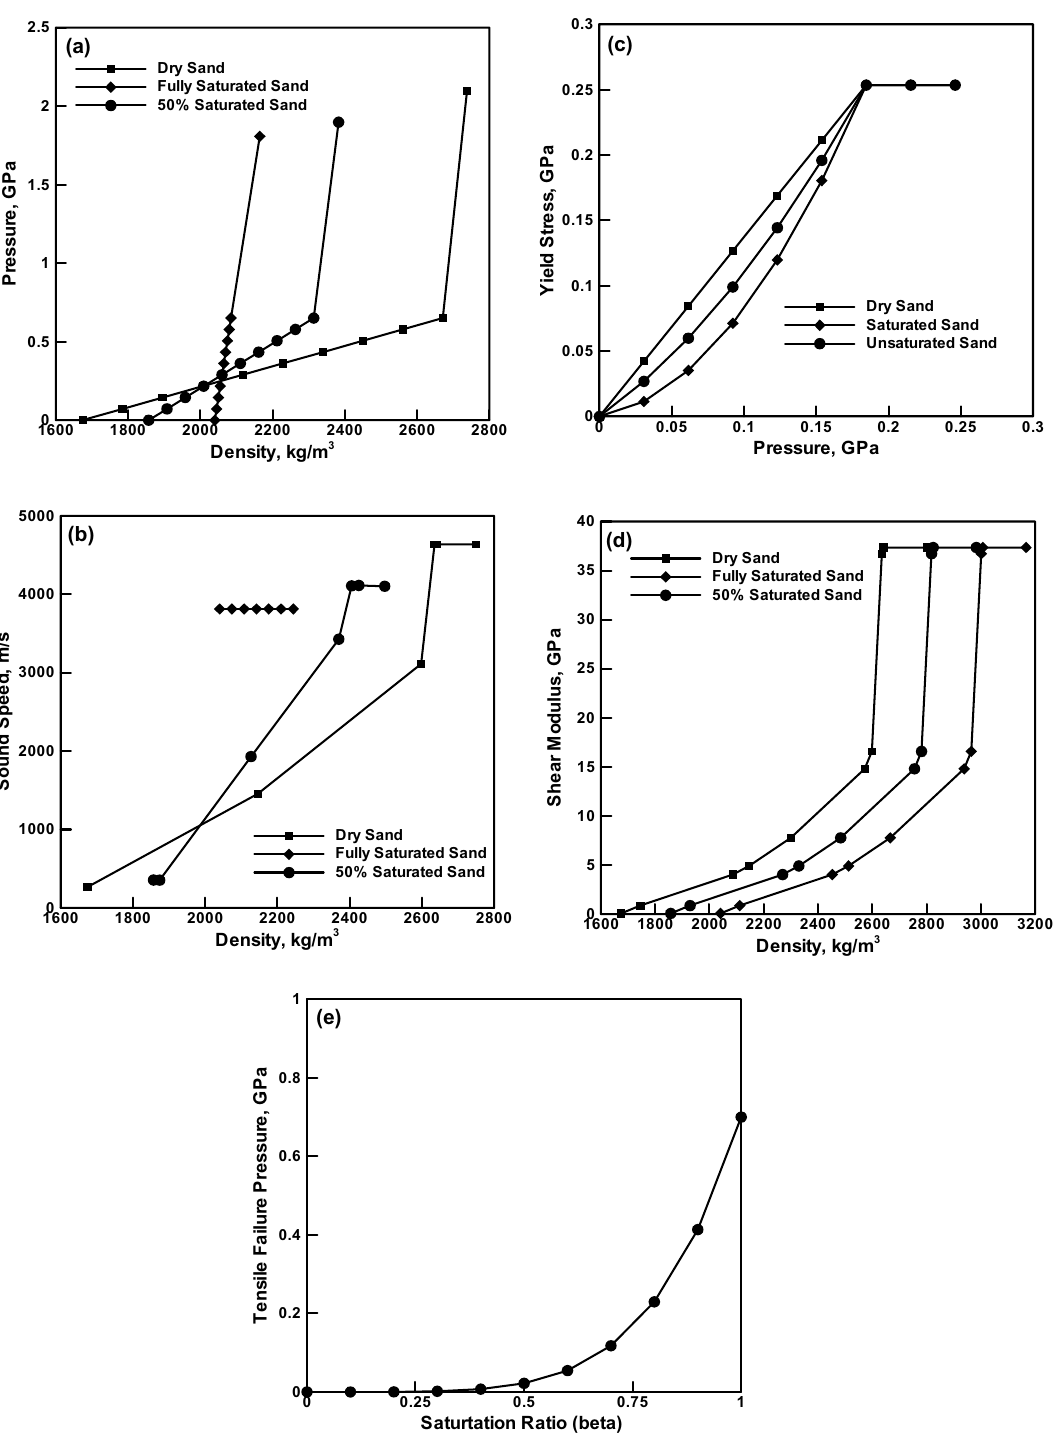
Fig. 3. Effect of the saturation ratio on the (a) pressure vs. density; (b) sound speed vs. density; (c) yield stress vs. pressure; (d) Shear modulus vs. density and (e) the magnitude of the negative failure